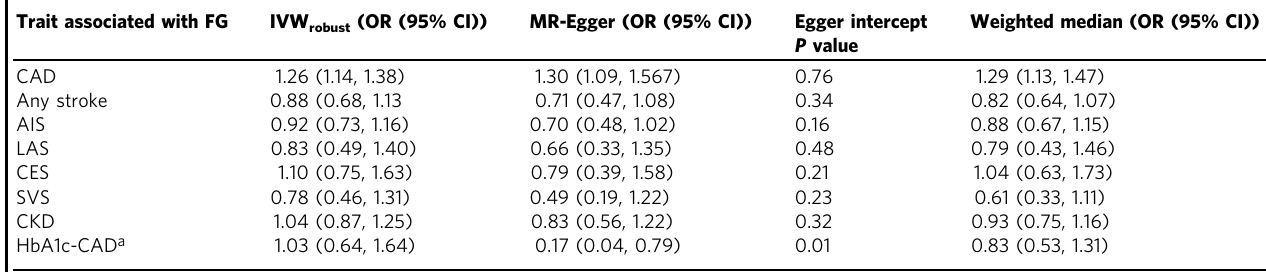
Table 1 Causal relationship between genetically determined prediabetes and vascular outcomes. Trait associated with FG